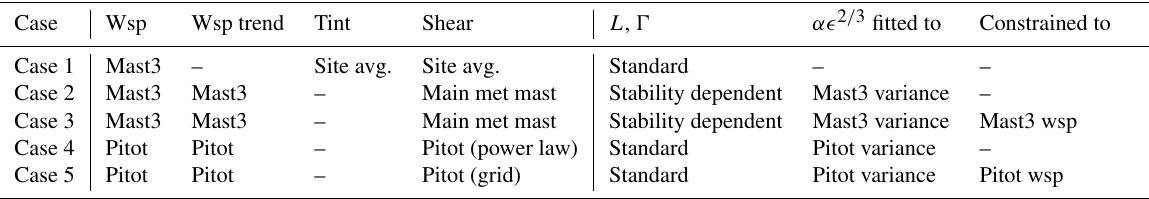
Table 1. Case overview showing the origin of the mean wind speed (wsp), wind speed trend, turbulence intensity (Tint), shear profile and Mann parameter ( L , (cid:48) and α(cid:15) 2 / 3 ) values that were used for each of the five cases. The last column shows which sensor was used as input for the constraint turbulence